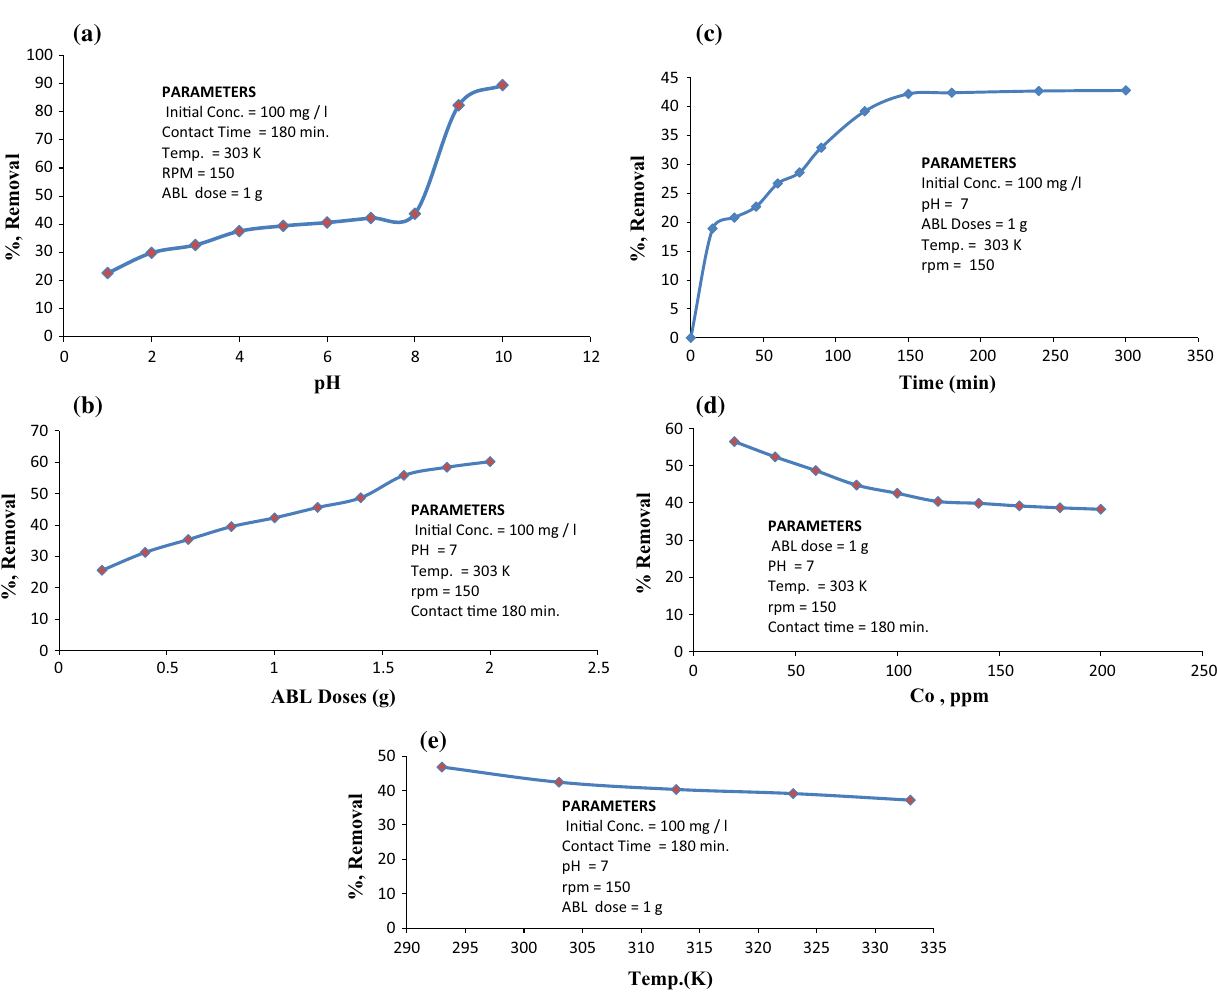
Fig. 2 Effect of parameters behaviour. a Effect of pH, b effect of dose, c effect of initial concentration, d effect of temperature, e effect of contact time